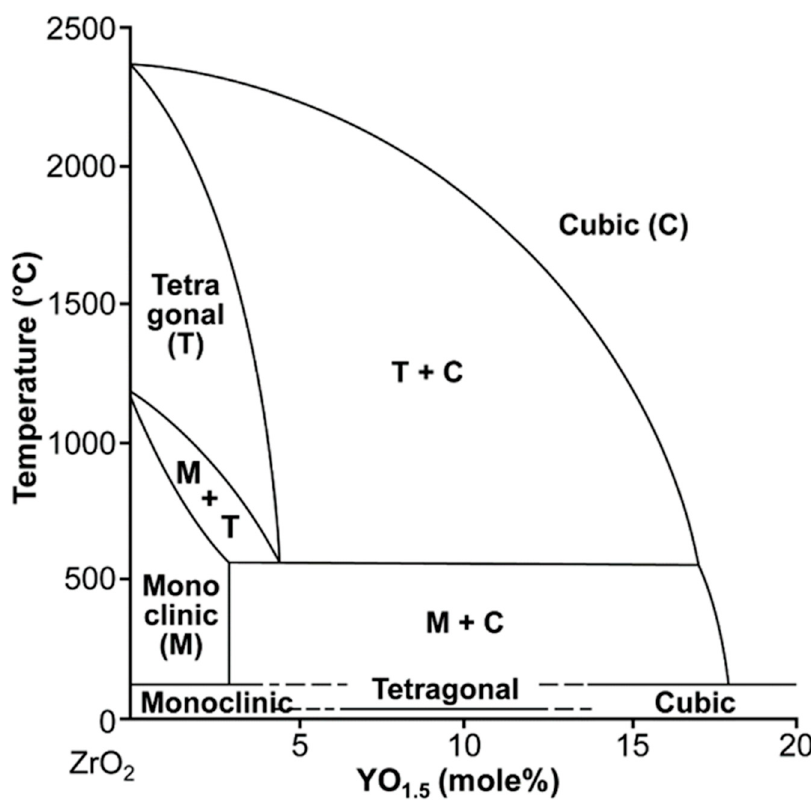
Figure 2. Zirconia-yttria phase diagram presented by Scott in 1975 [7].